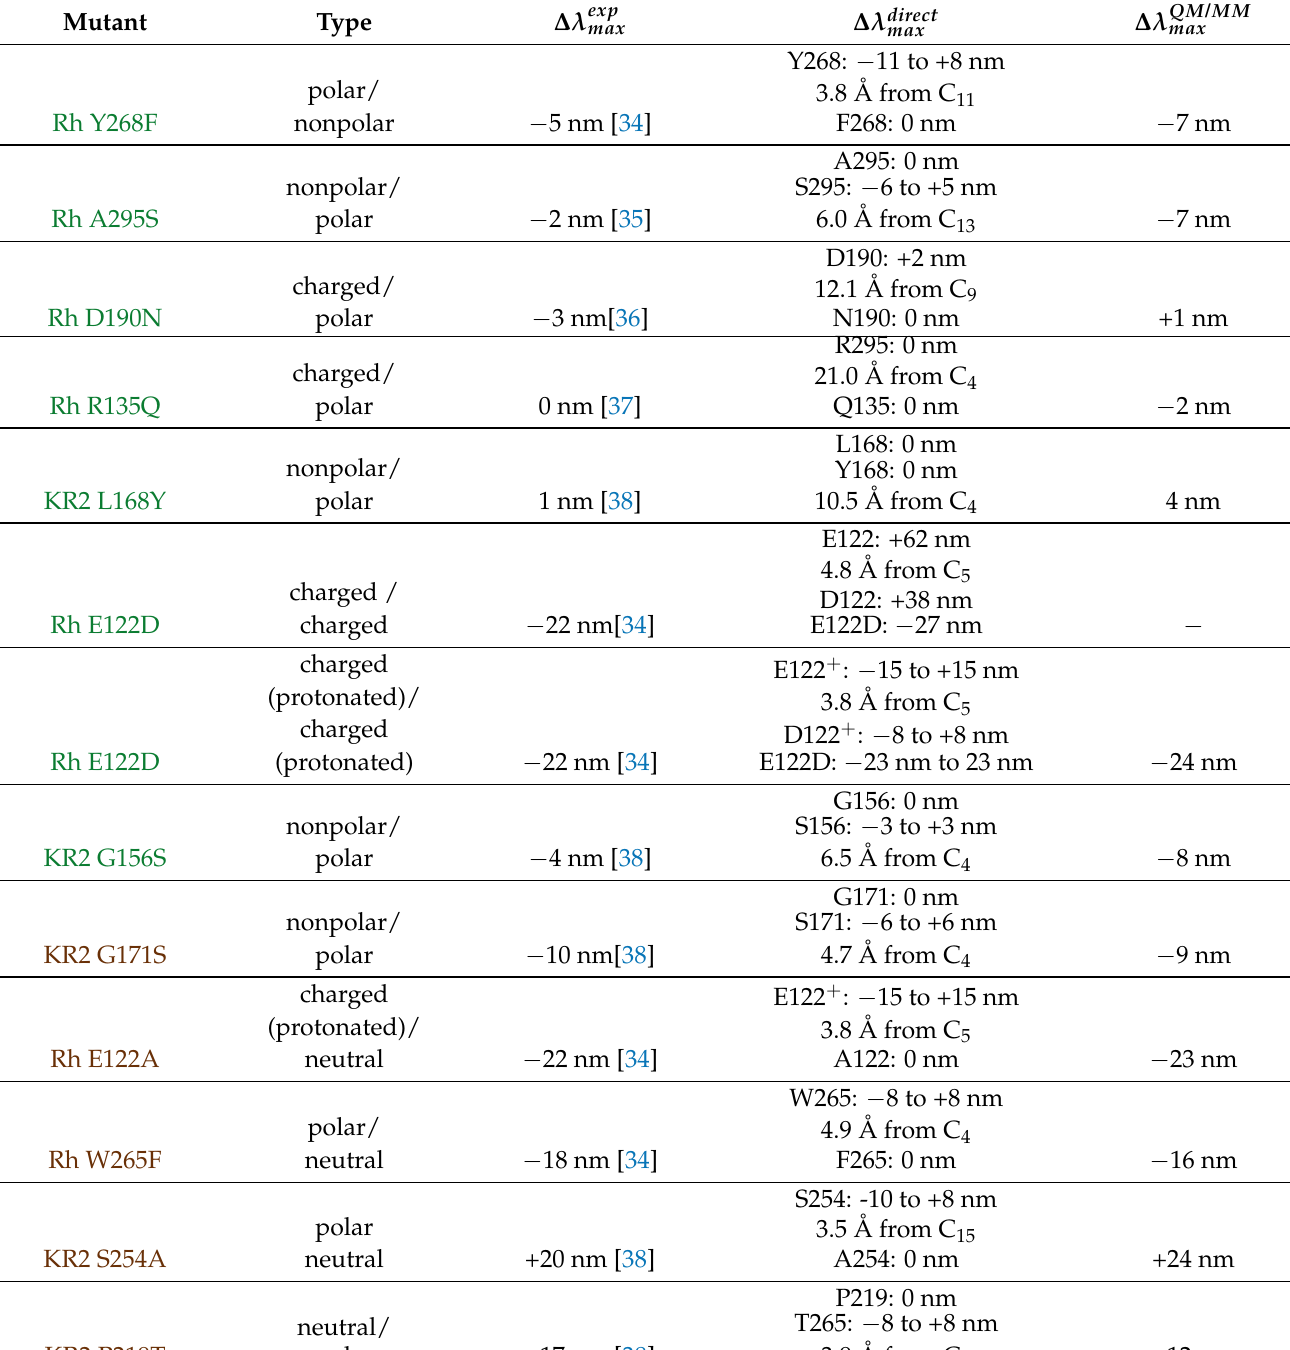
Table 1. Spectral shifts in bovine rhodopsin (Rh) and sodium pumping rhodopsin (KR2) caused by amino acid substitu- tions. ∆ λ exp max —experimental spectral shift. ∆ λ direct max —the magnitude of the spectral shift estimated by the proposed models (Figures 3, 5–7 and Tables S1–S6). ∆ λ QM / MM max —the spectral shift calculated with the quantum mechanics/molecular me- chanics models of rhodopsin mutants. Color coding: green—substitutions that do not induce structural reorganization (direct spectral tuning), brown—substitutions that cause a substantial structural reorganization (indirect spectral tuning).